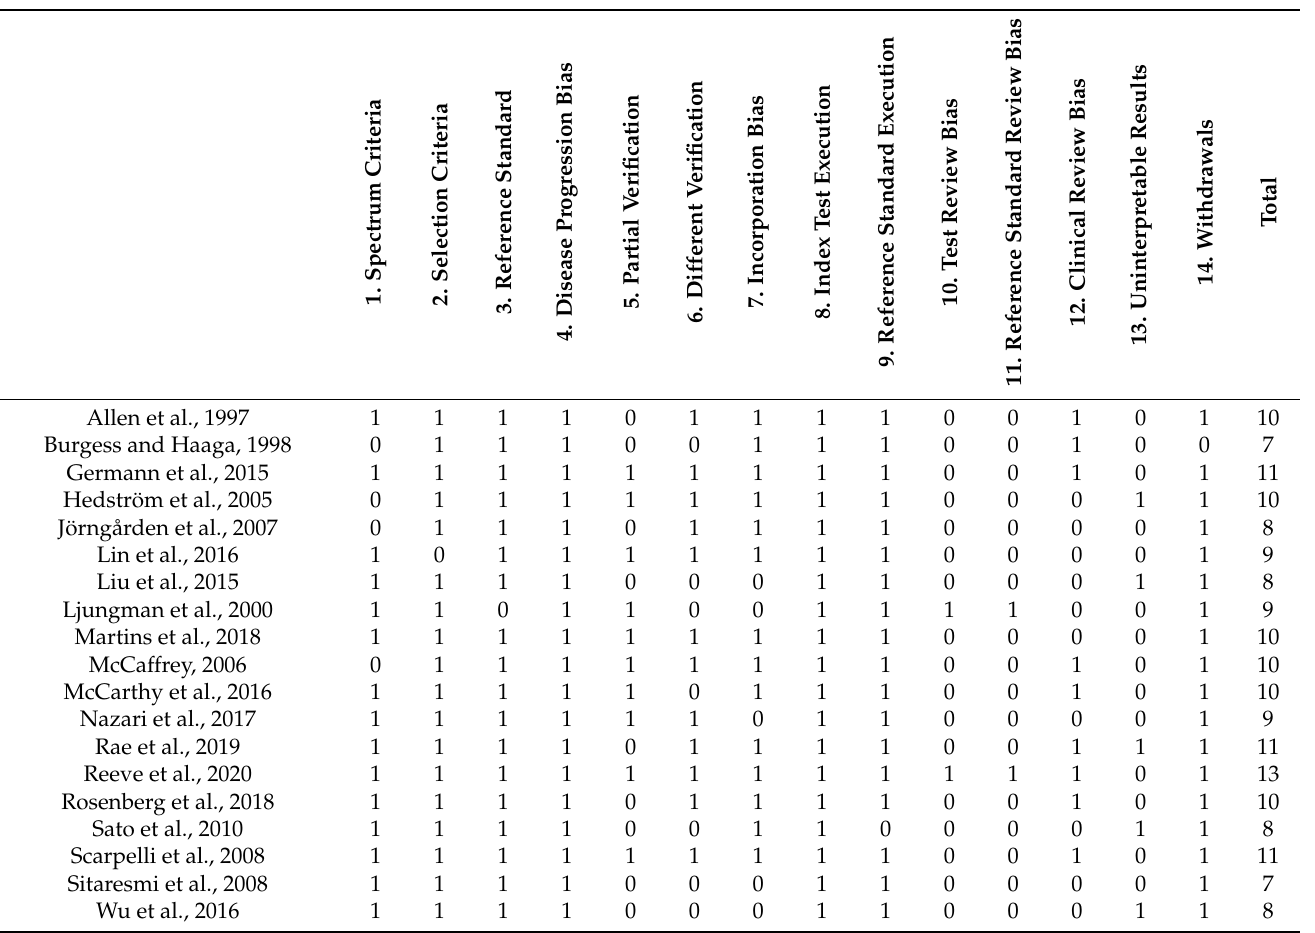
Table 1. Critical appraisal